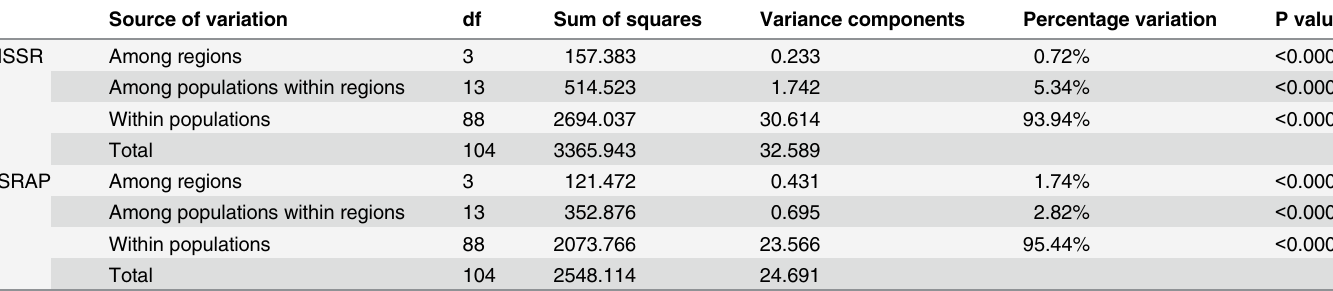
Table 6. Analysis of molecular variance (AMOVA) based on ISSR and SRAP